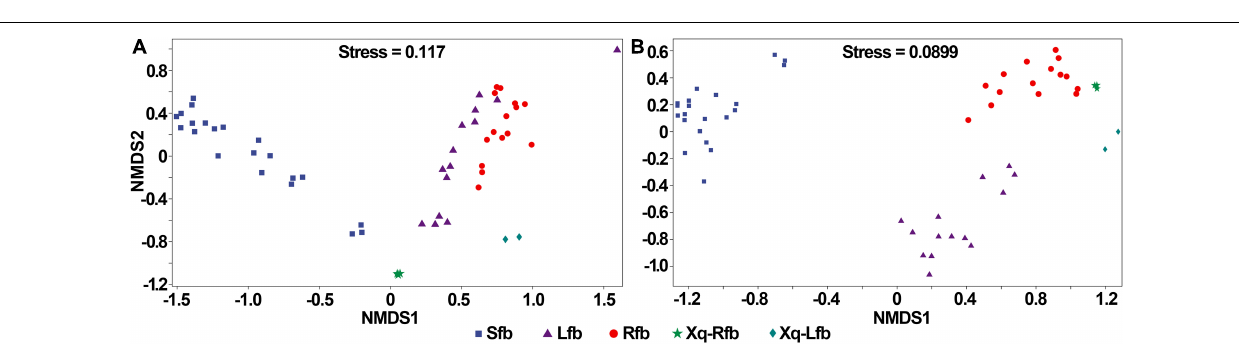
FIGURE 7 | Non-metric multidimensional scaling (NMDS) ranking of microbial community in production of rice-flavor baijiu, light-flavor baijiu, and strong-flavor baijiu. Bacteria (A) , and fungi (B) . Sfb, strong-flavor baijiu, fermented grains samples were separately collected on days 0, 7, 15, 25, 45, 70, and 95, n = 3; Lfb, light-flavor baijiu, fermented grains were separately collected on days 0, 1, 3, 5, 7,10, and 15, n = 2; Rfb, rice-flavor baijiu, samples collected in this study. Xq-Rfb, Xiaoqu used in rice-flavor baijiu, n = 3; Xq-Lfb, Xiaoqu used in light-flavor baijiu, n = 2. Sample information used for bacterial and fungal analyses were shown in Supplementary Tables 5, 6 ,